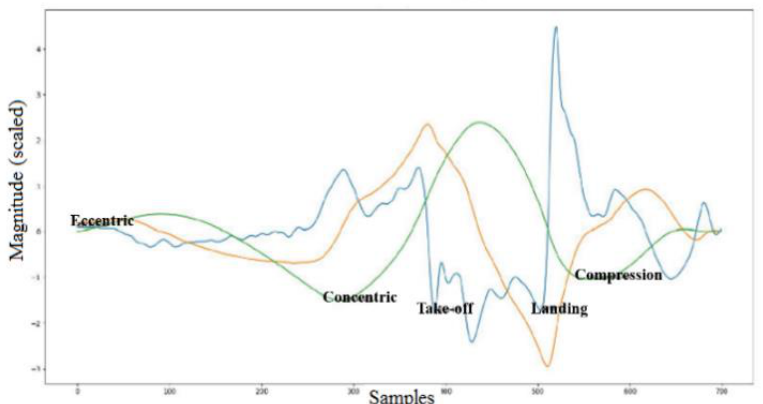
Figure 10. Example of event detection from the accelerometer in a countermovement jump. Force (blue), velocity (red), and displacement (green) curves are plotted and manually scaled to be shown in the same graph.